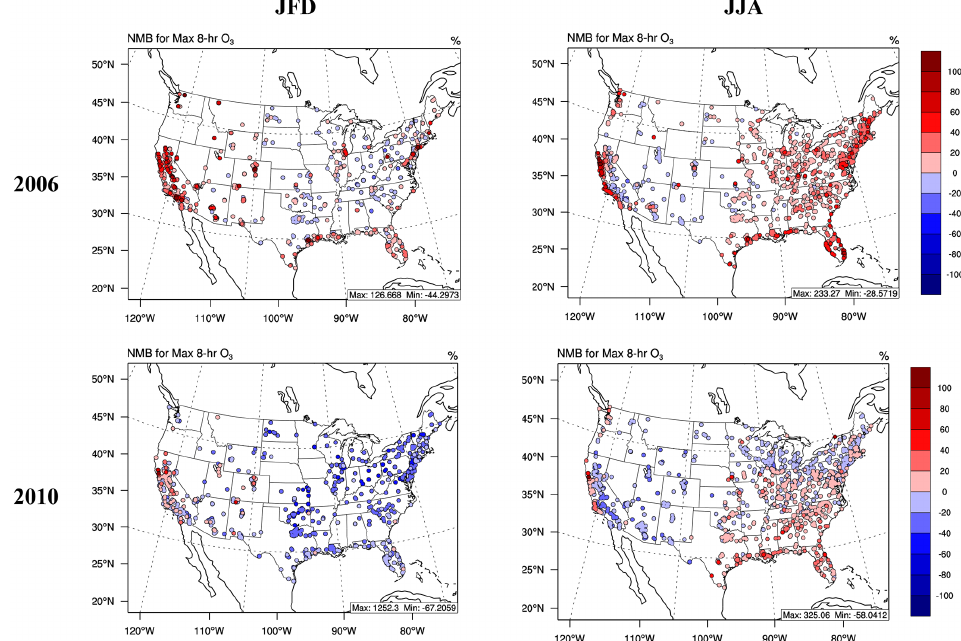
Figure 2. Spatial distribution of NMB plots for JFD and JJA 2006 and 2010 for maximum 8h O 3 concentrations, based on evaluation against CASTNET, AQS and SEARCH.